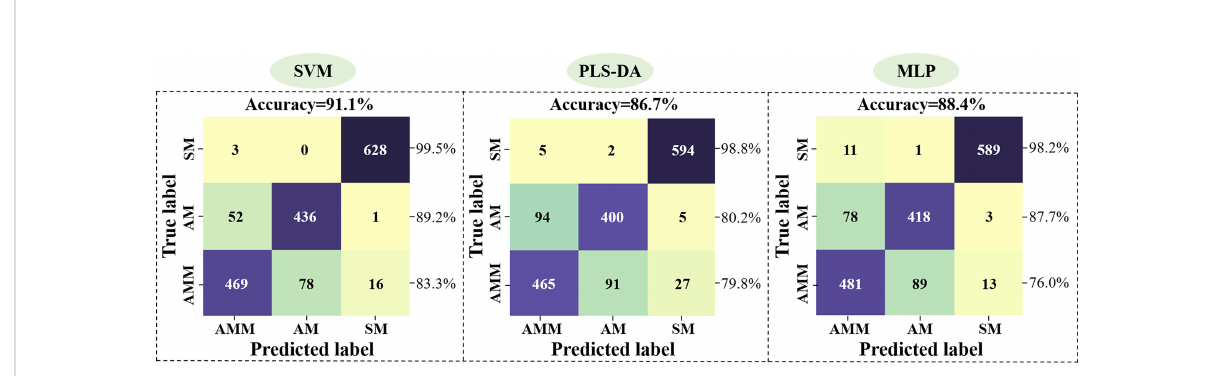
FIGURE 3 Performance of the SVM, PLS-DA, and MLP model validation sets based on machine vision data.